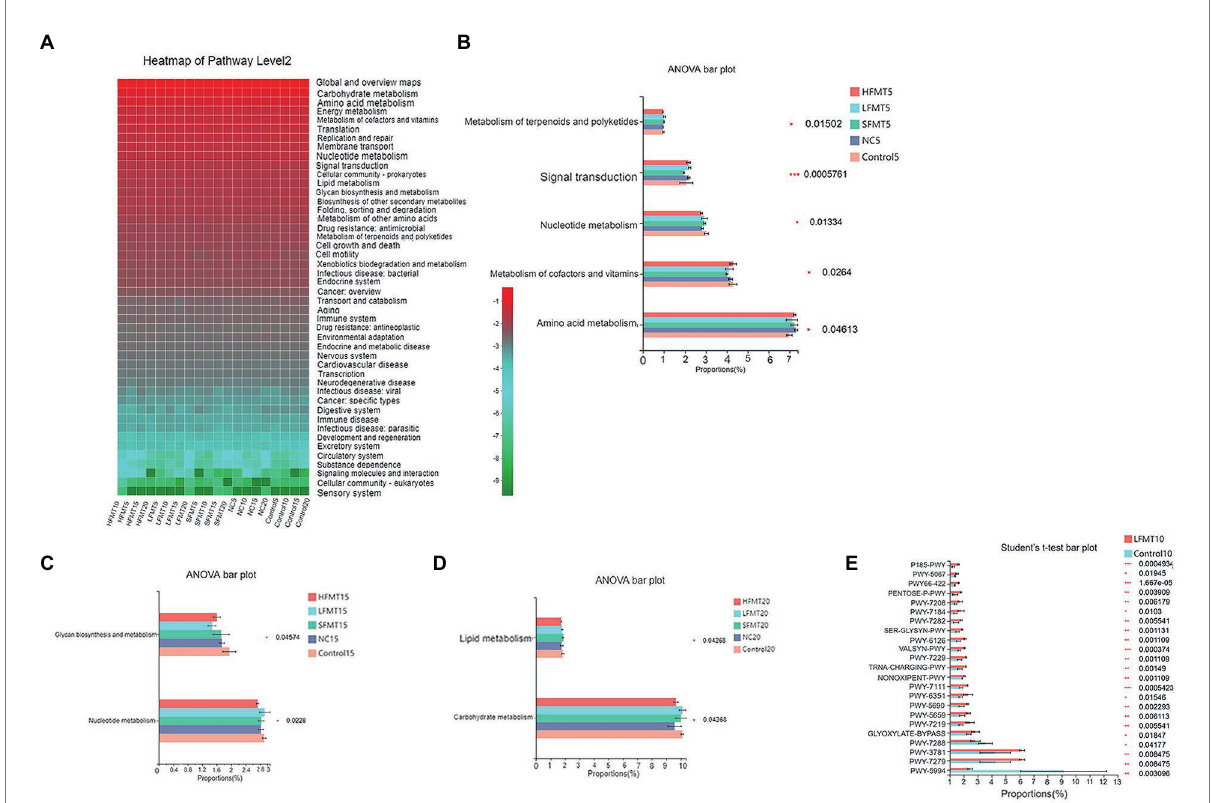
FIGURE 8 Functional prediction analysis of bacterial 16 s rRNA and ITS gene sequences based on KEGG database and MetaCyc database, respectively. (A) Relative enrichment of KEGG Level 2 in different treatment groups. (B) One-way ANOVA of KEGG Level 2 levels in each treatment group 5 days after weaning. (C) One-way ANOVA of KEGG Level 2 in each treatment group 15 days after weaning. (D) One-way ANOVA of KEGG Level 2 in each treatment group 20 days after weaning. (E) Student’s t -test was performed on the functional pathways of each treatment group based on MetaCyc database 10 days after weaning.PWY-7279 [aerobic respiration II (cytochrome c; yeast)], PWY-3781 (aerobic respiration I (cytochrome c)), GLYOXYLATE-BYPASS (glyoxylate cycle), PWY-5994 (palmitate biosynthesis I (animals and fungi)), PWY-7282